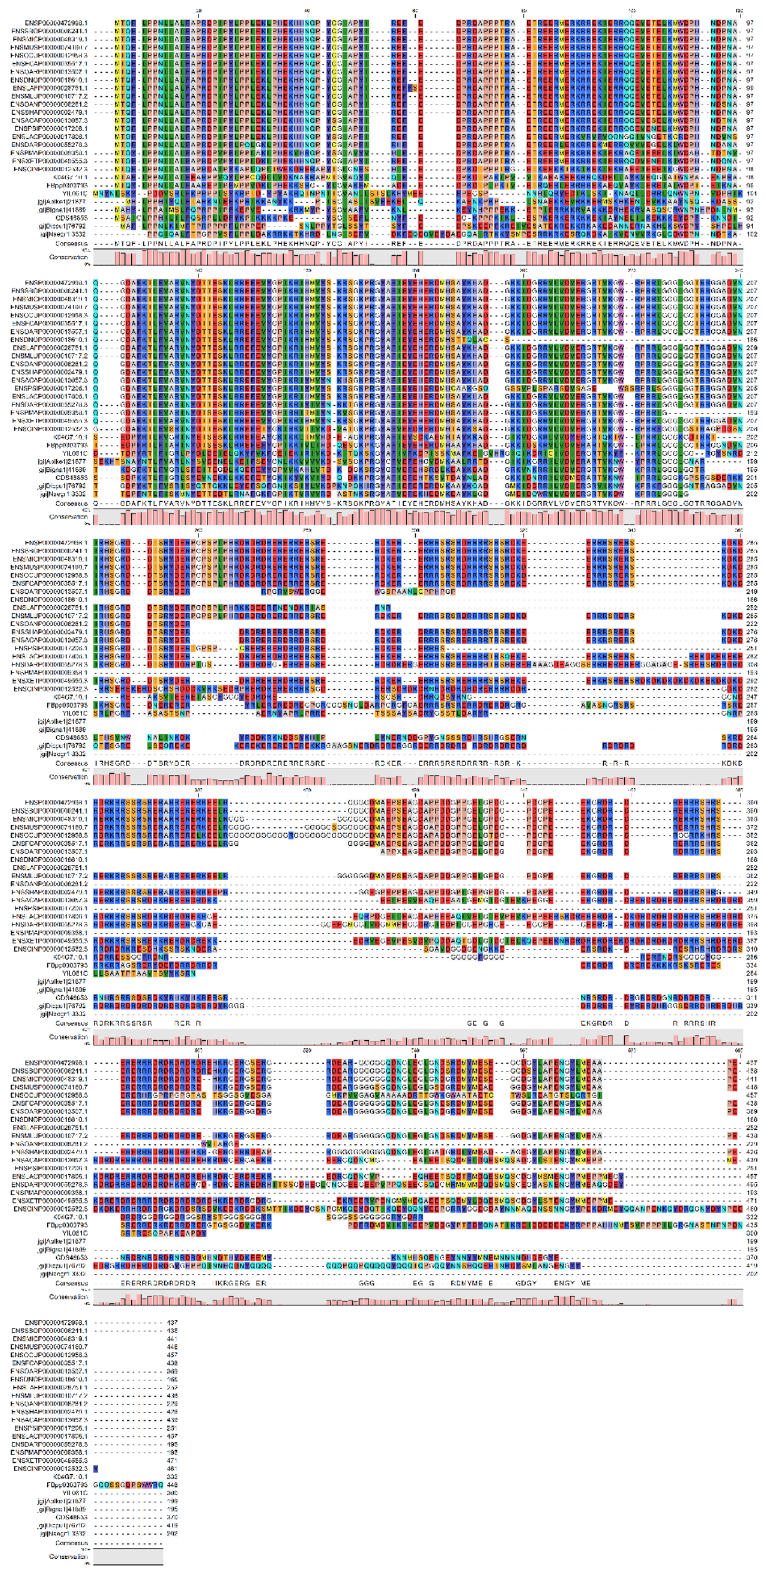
Figure 2. Multiple sequence alignment by using 27 representative animal U1-70K sequences for phylogenetic tree